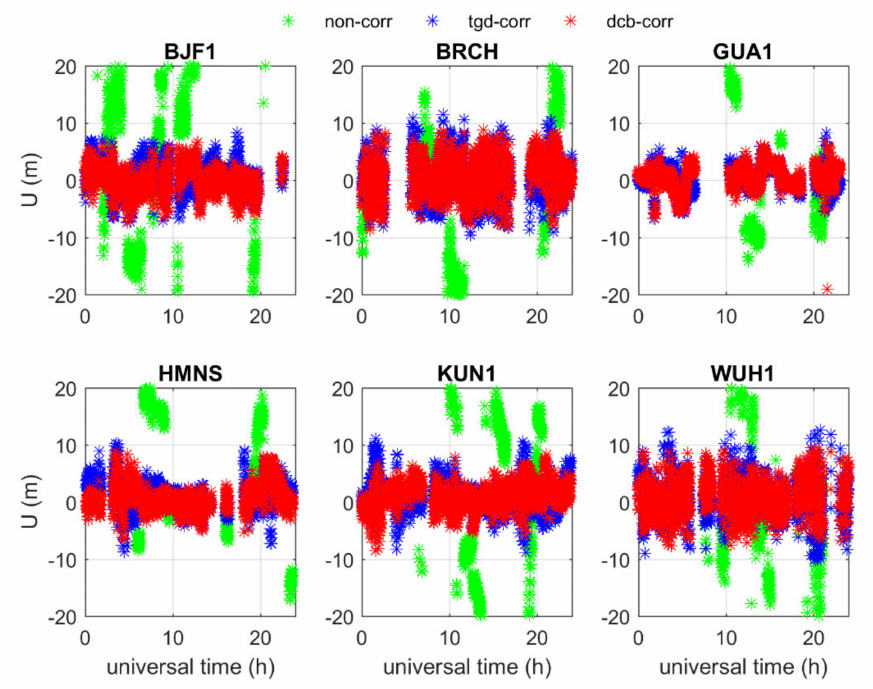
Figure 16. Vertical positioning error scatters with and without TGD or DCB correction of B1I/B3I SPP at six